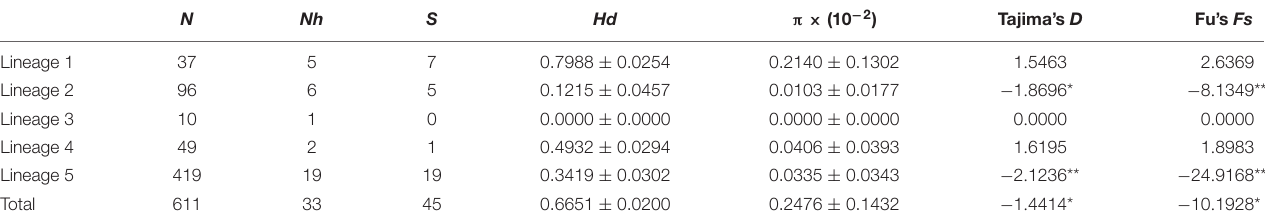
TABLE 1 | Molecular diversity for four lineages of Agarophyton vermiculophyllum in the northwest Pacific. N